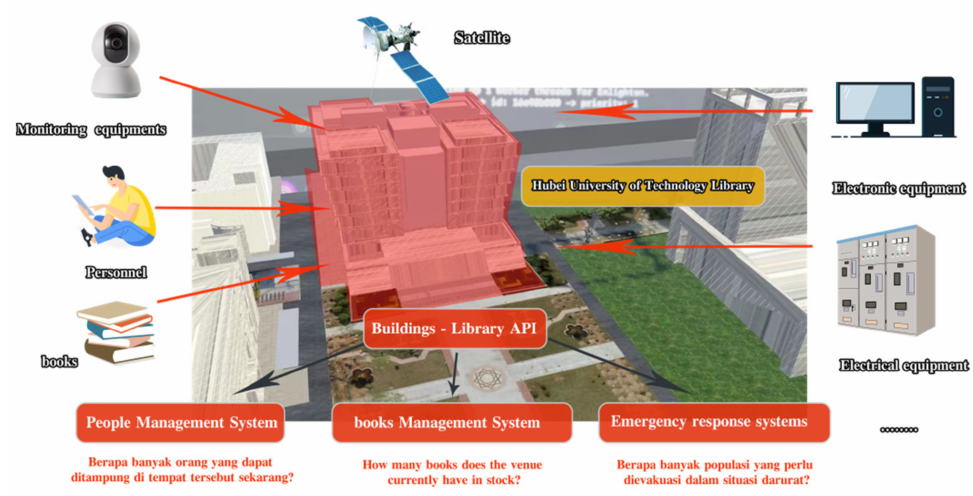
Figure 8. Dynamic data presentation in the library.